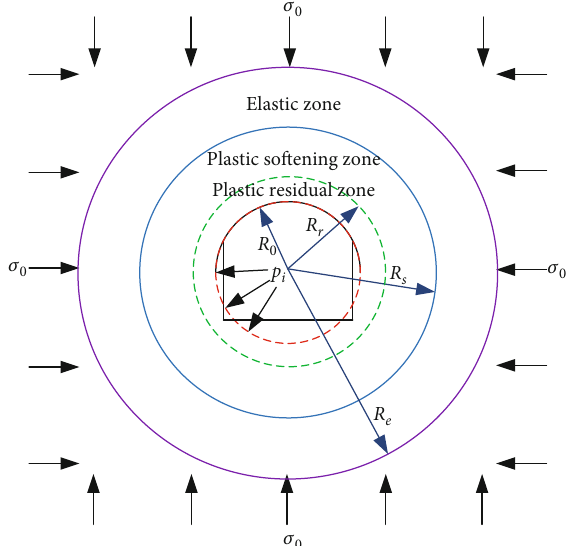
Figure 2: Partition diagram of an equivalent circular roadway after excavation.